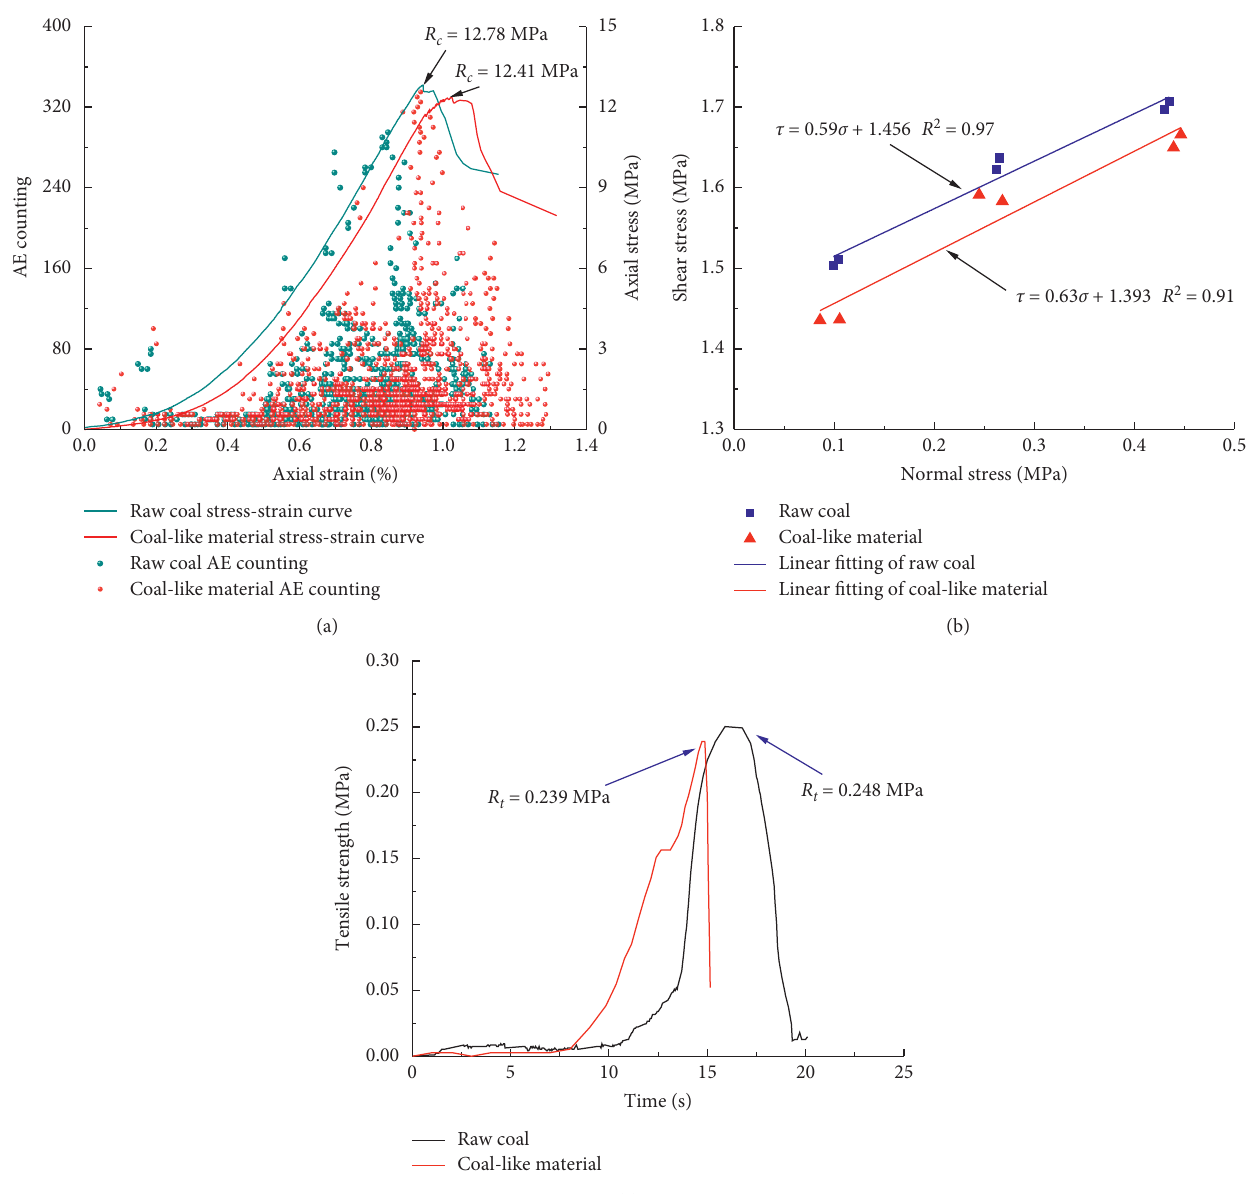
Figure 1: Mechanical and acoustic emission properties of coal-like material. (a) Typical curves of uniaxial stress strain. (b) Typical curves of variable-angle shear strength and AE counting. (c) Typical curves of tensile strength.